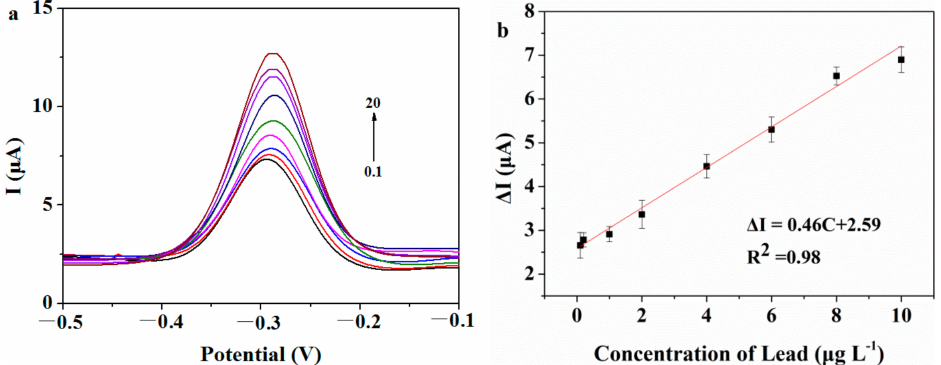
Figure 4. ( a ) Differential Pulse Voltammetry (DPV) responses to aptasensor capturing a series of concentrations of Pb 2+ from 0.1 to 20 µ g L − 1 , ( b ) calibration curve of ∆ I and Pb 2+ concentration.